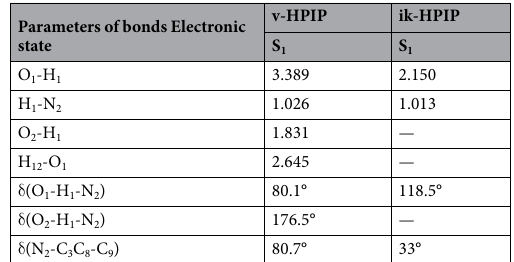
Table 4. The bond parameters (bond length (Å), length angle (°) and dihedral angle (°)) of crucial moiety for the v-HPIP and ik-HPIP in the S 1